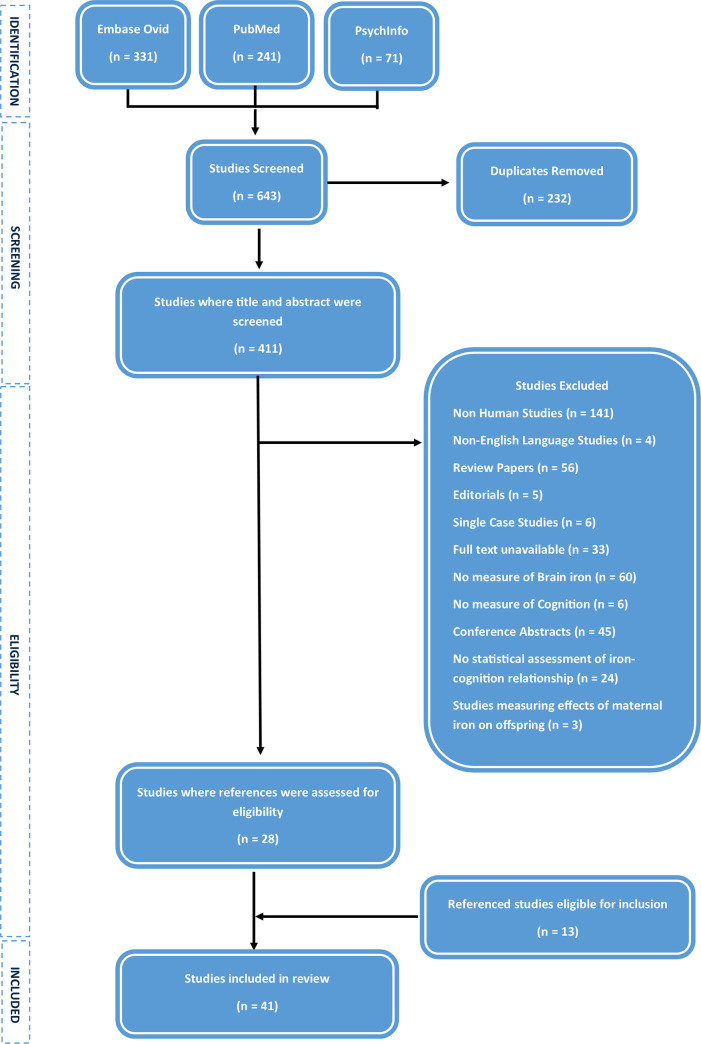
Flowchart detailing the study selection procedure.